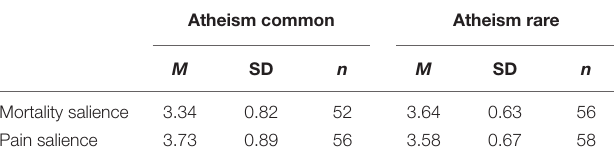
TABLE 1 | Descriptive statistics of atheists’ meaning in life in each cell. Atheism common Atheism